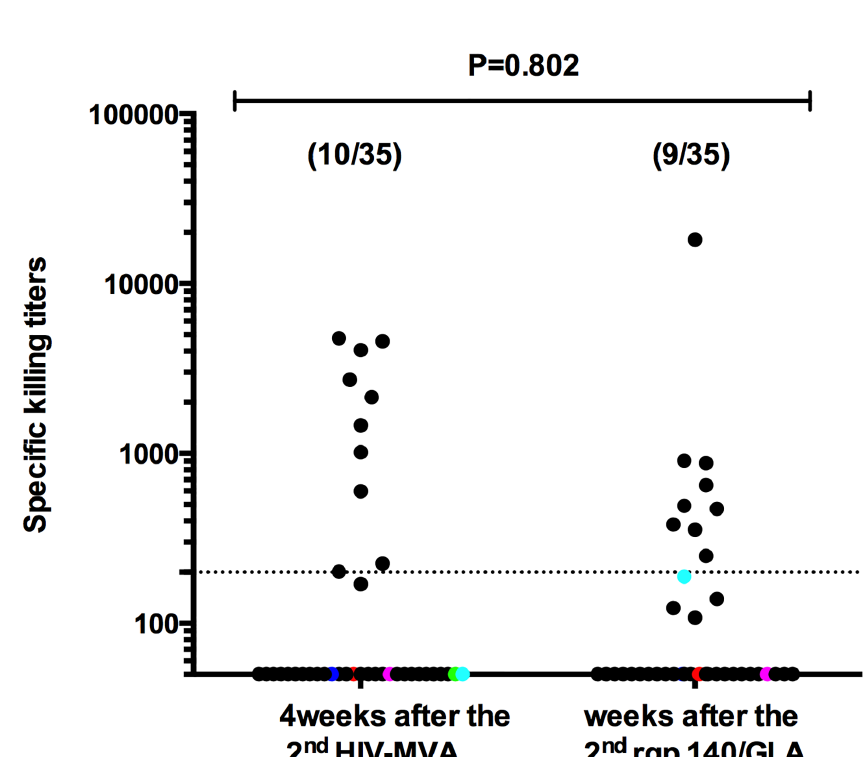
Fig 3. ADCC-mediating responses to CM235 CRF01_AE infected IMC. ADCC mediating antibodies four weeks after receipt of three HIV-DNA and two HIV-MVA vaccinations and four weeks after two CN54rgp140/ GLA-AF immunizations are shown. Black dots show vaccinees who received 7 vaccinations, while colored dots show unprimed vaccinees who received two CN54rgp140/GLA-AF immunizations only. The Mann- Whitney test was used for statistical